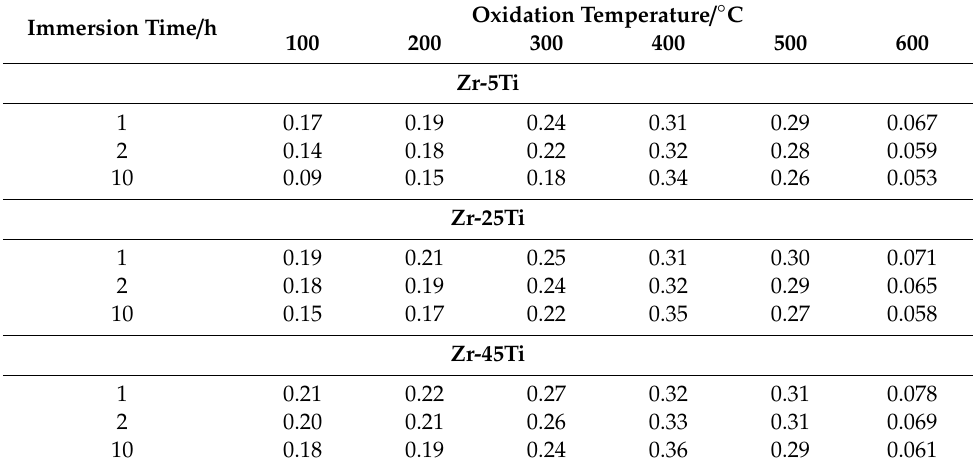
Table 7. Values of the polarization resistance (in M Ω · cm 2 ) as a function of immersion time of thermally oxidized Zr-Ti alloys in phosphate bu ff ered saline solution acidified at pH = 8.1 ± 0.1 Oxidation Temperature / ◦ Immersion Time / h